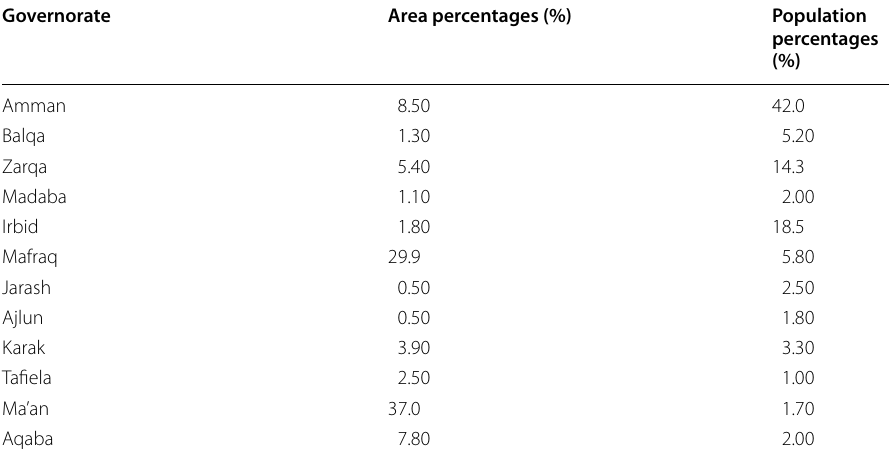
Source: Department of Statistics, 2018. Jordan. Estimated population of 2018 and some of selected data report